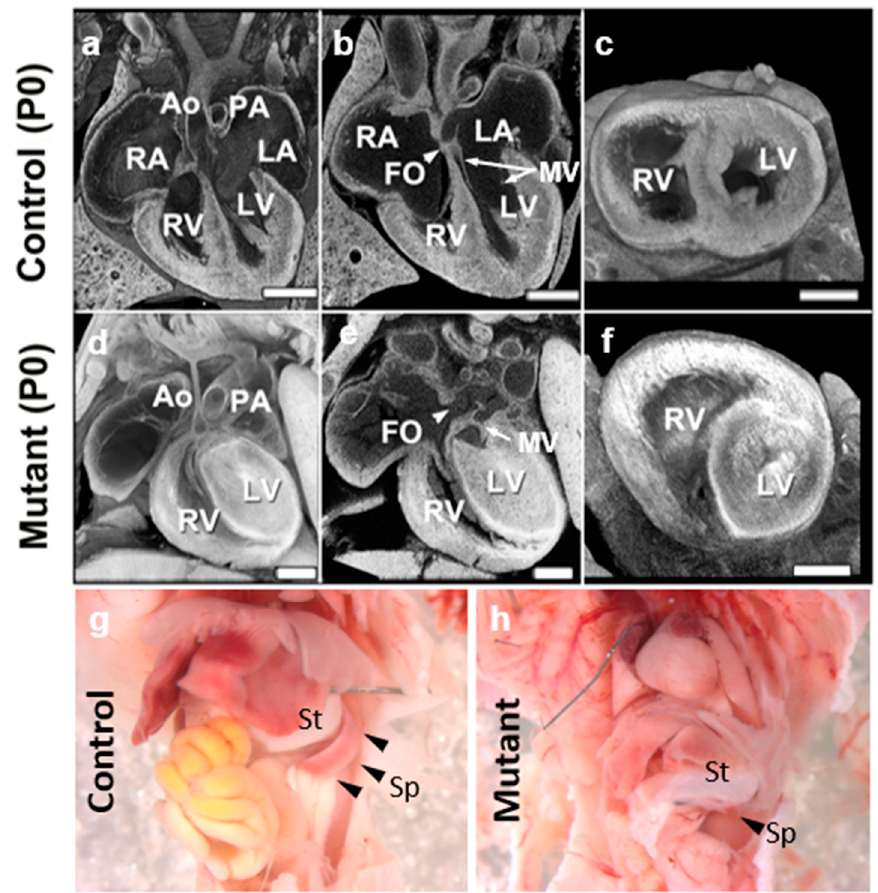
Figure 1. Ohia HLHS mutant mice exhibit left heart and spleen hypoplasia. ( a – f ) Histopathology showing the cardiac anatomy of HLHS mutant mouse and littermate control at birth (P0). Note the muscle-bound LV with no lumen, hypoplastic aorta, aortic valve atresia, and mitral valve (MV) hy- poplasia/stenosis, and patent foramen ovale (FO) denoted by white arrowhead. The interventricular septum is intact in the mutant mouse. ( g , h ) Newborn wildtype ( g ) and Ohia mutant ( h ) mice. Spleen (black arrowheads in ( g , h )) hypoplasia is observed in the Ohia mutant as compared to the wildtype (see black arrowhead) mouse. LA, left atrium; RA, right atrium; LV, left ventricle; RV, right ventricle, MV: mitral valve, St; Stomach, Sp; Spleen. Scale bars: 0.5 mm